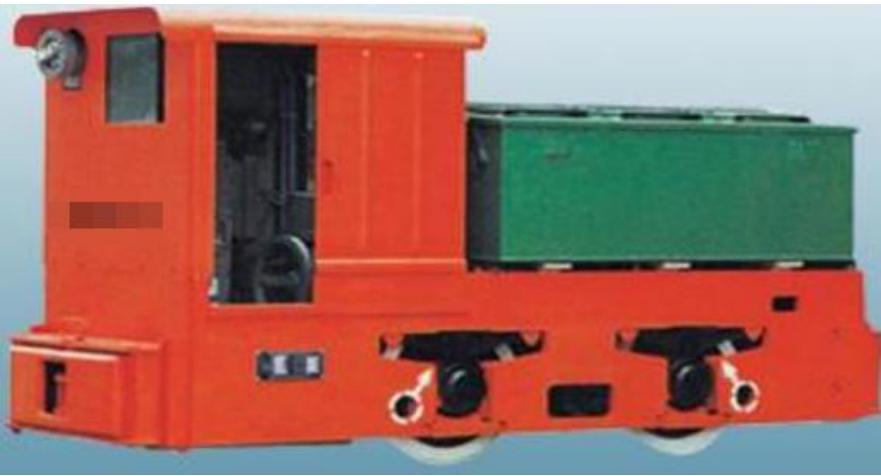
Figure 1. The electric vehicle in the underground mine.